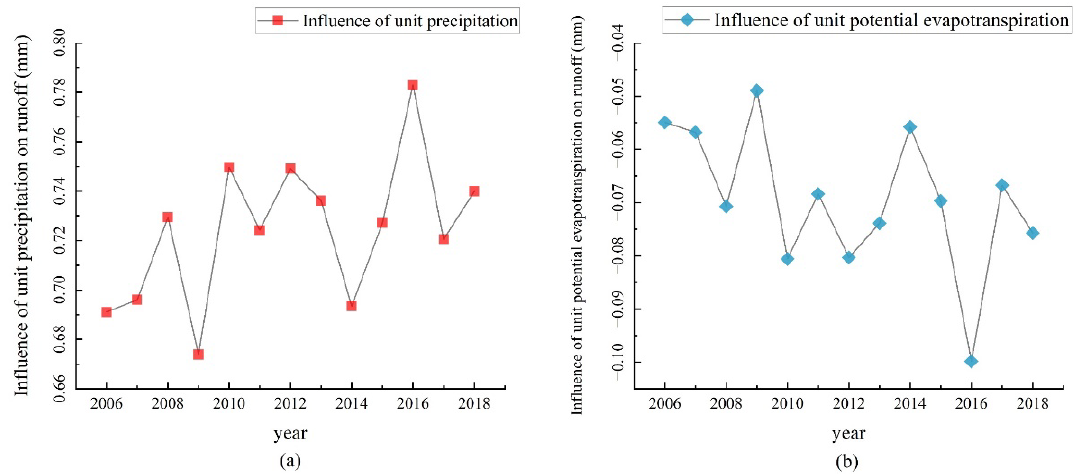
Figure 6. Impact of unit precipitation and unit potential evaporation changes on runoff depth. ( a ) and ( b ) were the variations of runoff depth when unit precipitation and unit potential evaporation increased, respectively.